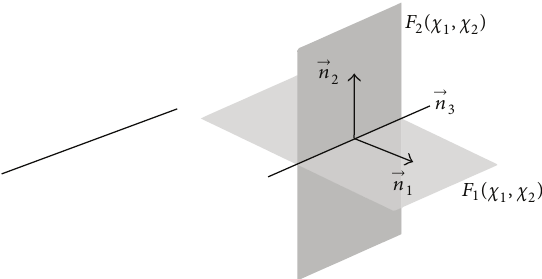
Figure 1: The geometry of complex linearization. The straight line on the left is a solution of a linear second order real ODE. The concept naturally extends in the complex domain where a straight line arises in the intersection of two perpendicular planes determined by 𝐹 1 and 𝐹 2 which are linear functions of 𝜒 1 and 𝜒 2 . The third axis is then naturally given by ⃗𝑛 1 × ⃗𝑛 2